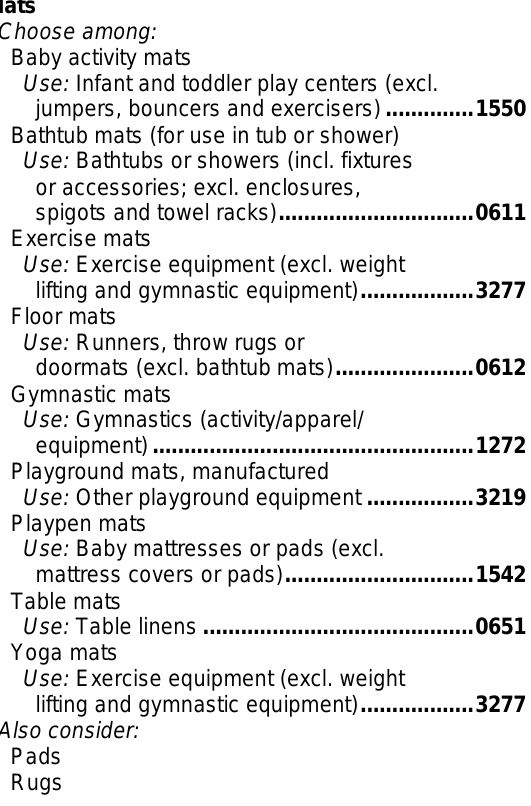
Markers, sewing Use: Sewing basket articles (excl. scissors,